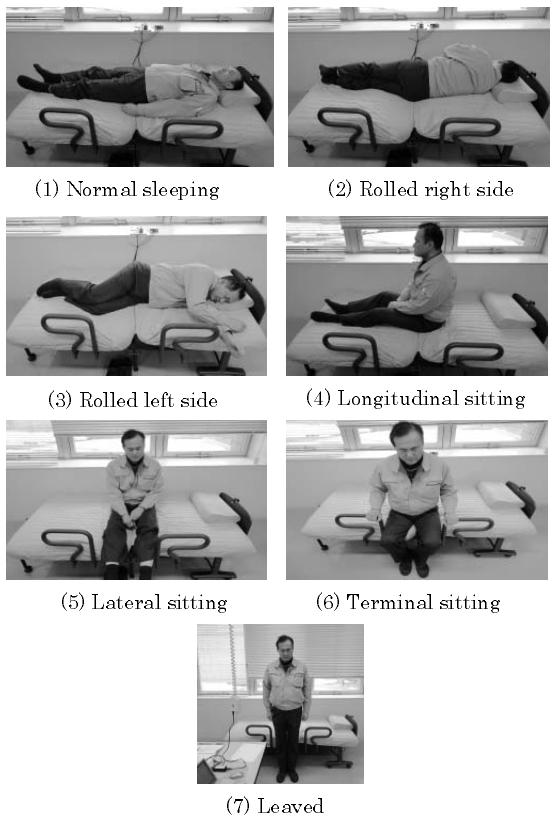
Figure 5. Behavior patterns for detection and recognition of bed- leaving.